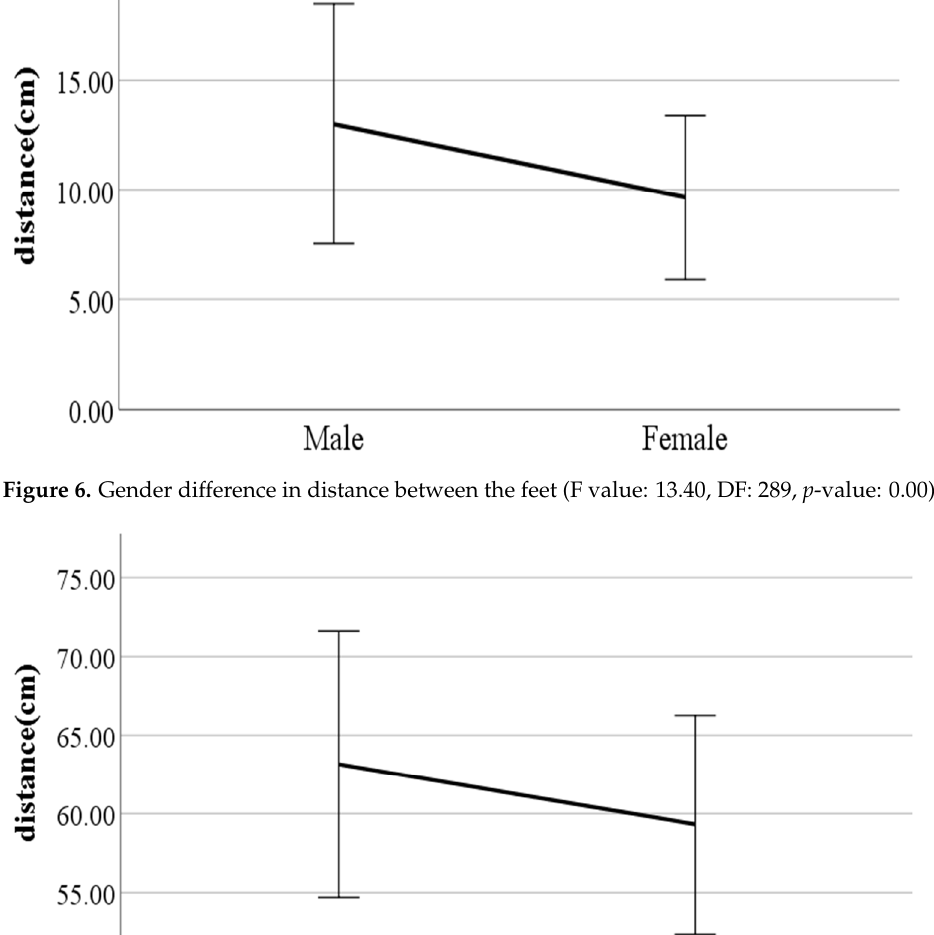
Figure 8. Gender difference in walking speed (F value: 3.58, DF: 289, p -value: 0.00). Figure 9. Gender difference in the ratio of swing phase (F value: 0.31, DF: 289, p -value: 0.04).